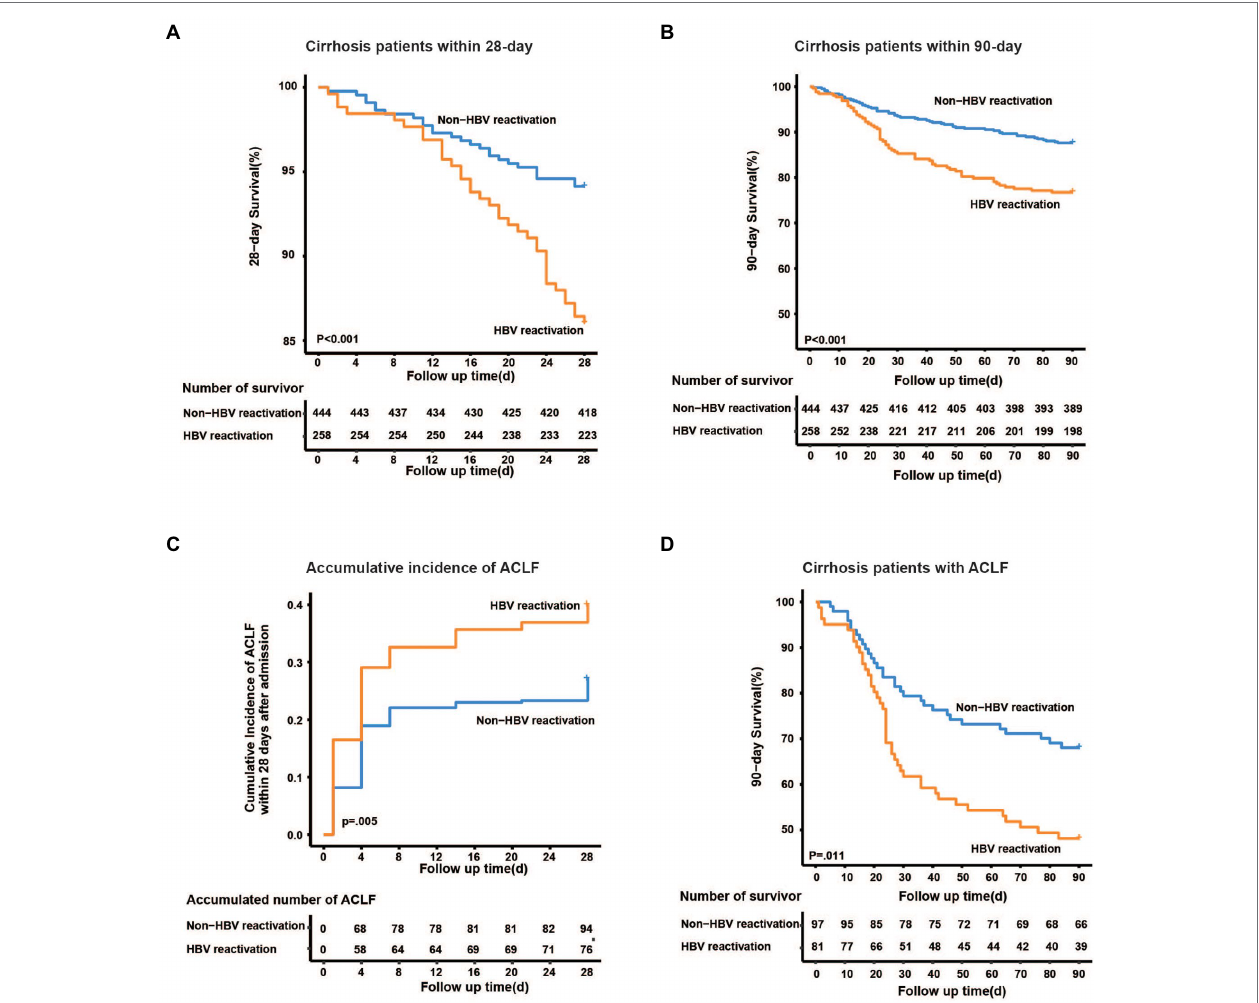
FIGURE 4 | Kaplan–Meier analysis of survival rate and accumulative developing of ACLF. Kaplan–Meier curves are shown for the cumulative incidence of 28-day death (A) , 90-day death (B) and developing of ACLF (C) in cirrhotic patients with and without HBV reactivation. (D) Cumulative 90-day mortality in ACLF patients between